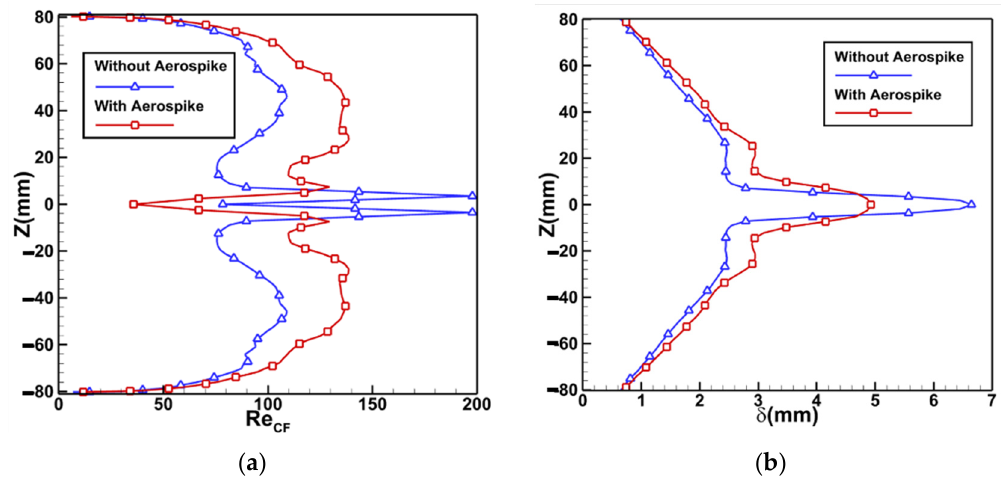
Figure 10. Comparison of τ cross distribution. ( a ) with aerodisk, ( b ) without aerodisk.